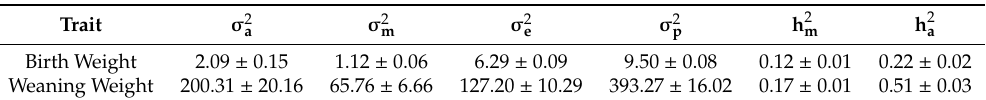
Table 2. Variance components, direct and maternal heritability estimates for birth weight and weaning weight of Hanwoo calves.